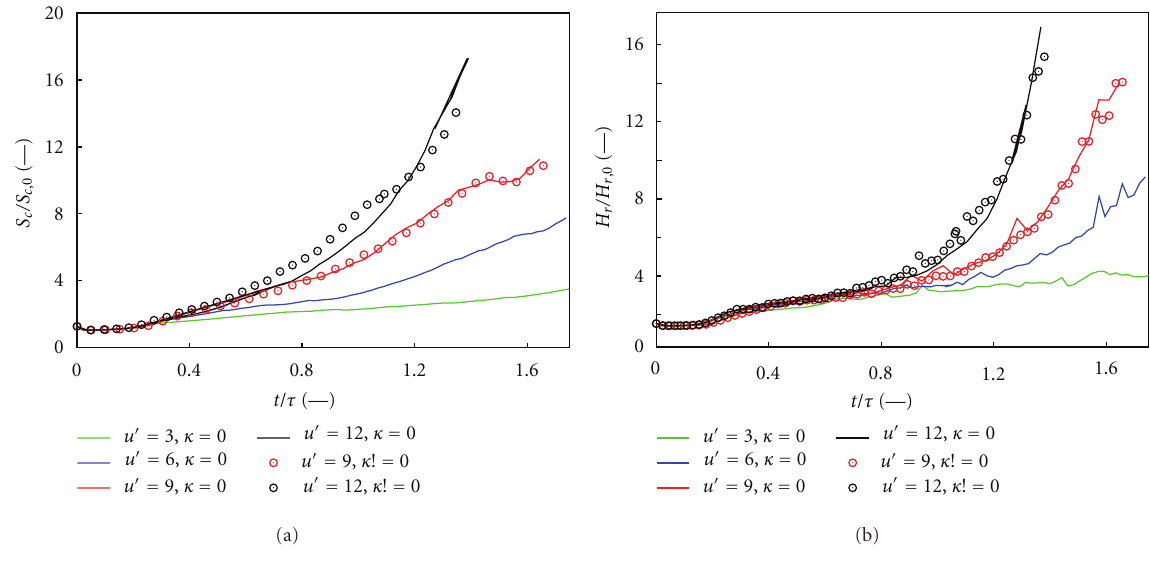
Figure 9: Temporal evolution of the scaled (a) fuel consumption and (b) integrated heat release rates at di ff erent turbulence intensities for stoichiometric premixed methane-air flames with (circle points: cases 3 and 4 ) and without (solid line: cases 1–4 ) volume viscosity e ff